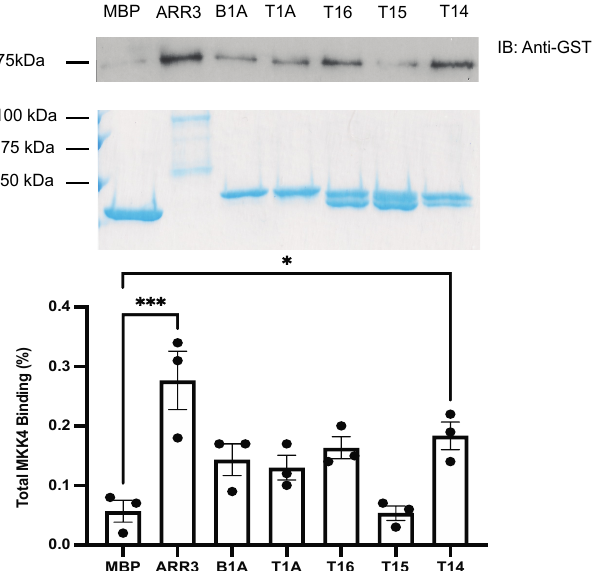
Figure 3. MBP pull-down of GST-MKK4. Purified MBP fusions of indicated peptides and full- length arrestin-3 (10 µ g) were immobilized on amylose resin and incubated with purified GST-MKK4 (5 µ g), as described in the methods. The beads were washed, and bound proteins were eluted with 50 mM maltose. Aliquots of eluates were subjected to SDS-PAGE. The loading of MBP constructs was assessed by Coomassie staining (middle panel). MKK4 binding was measured by Western (top panel). Densitometric quantification (bottom panel) was performed using ImageJ software [26]. Dots represent measurements in individual experiments. Statistical analysis was performed using one-way ANOVA followed by Dunnett’s post hoc test with correction for multiple comparisons ( n = 3). *, p < 0.05; ***, p < 0.0005 to MBP control. Part of these data (the first four columns) was previously published in [21].